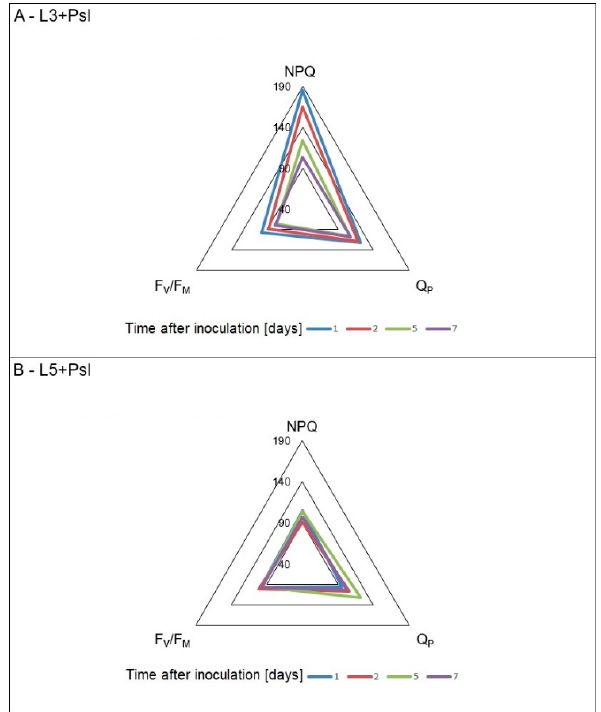
Figure A1. Relative changes of mean values of fluorescence parameters in cucumber plants infected with Psl . ( A ) The 3rd inoculated leaves; ( B ) the 5th non-inoculated leaves collected from the inoculated plants. All fluorescence data relative to respective control plants. Table A1. Relative activities of superoxide dismutase (SOD) isoforms after native gel electrophoresis (PAGE).